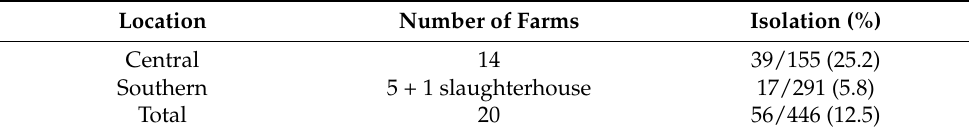
Table 3. STEC screening and isolation rates in cattle from central and southern farms in